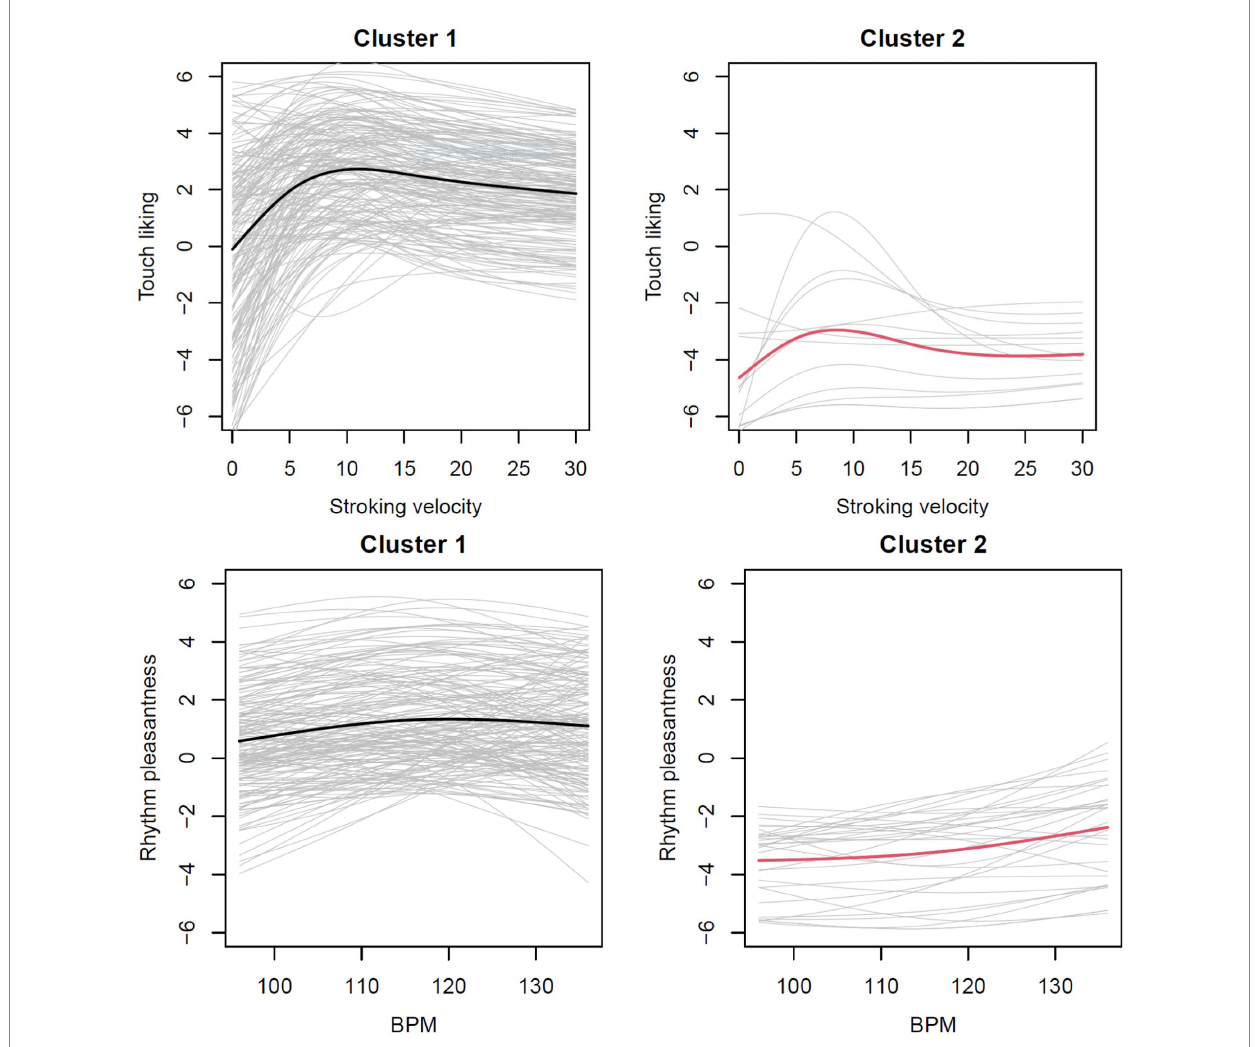
FIGURE 14 Clustering identified three different mean groups for touch ratings (upper) and two different mean groups for beat ratings